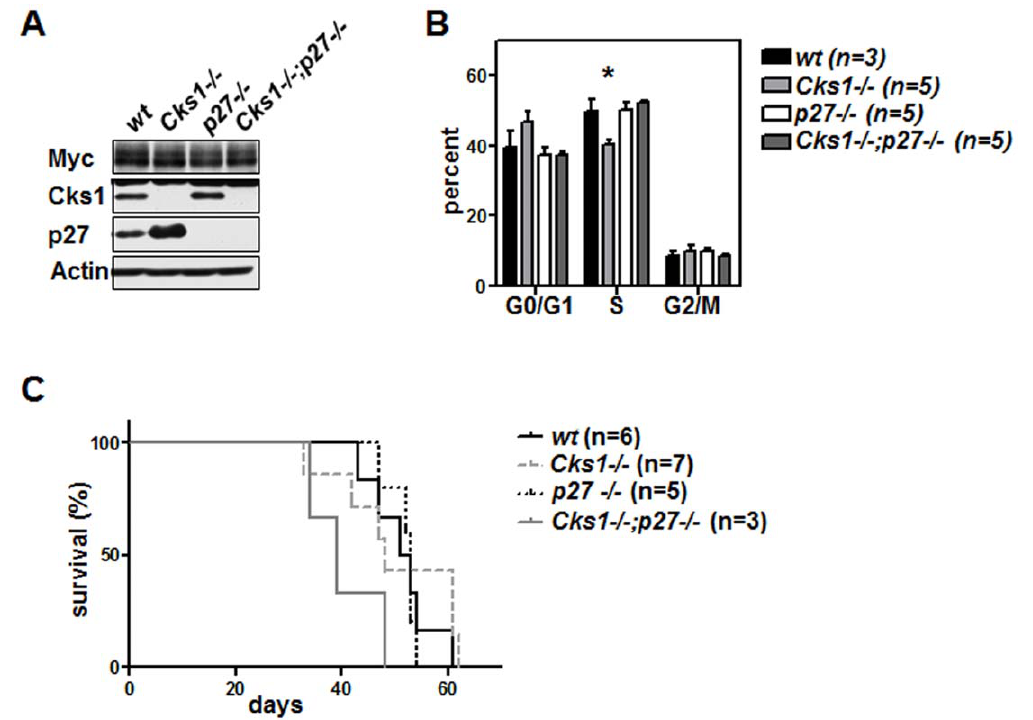
Figure 5. Cks1 regulates proliferation in oncogene-induced AML by suppressing p27 Kip1 . A , 5-FU-mobilized bone morrow from mice of the indicated genotype was infected with Myc-GFP virus and 2 6 10 6 GFP-positive cells were transplanted with an infection rate of about 40% into lethally irradiated recipients. Immunoblot analysis of the indicated proteins was performed 3 weeks after transplantation. B , Flow cytometric anti- BrdU staining of GFP-positive Gr1/CD11b-positive bone marrow cells. 1 mg BrdU/g body weight was intraperitoneally injected 12 hours before bone marrow harvest. The bars represent the mean 6 standard deviation of n=3 or 5 individual mice per genotype. C , Survival curve of mice transplanted with Myc-GFP -infected bone marrow of the indicated Cks1 and p27 Kip1 genotype. All mice died from AML. The median survival is not significantly different between the genotypes.